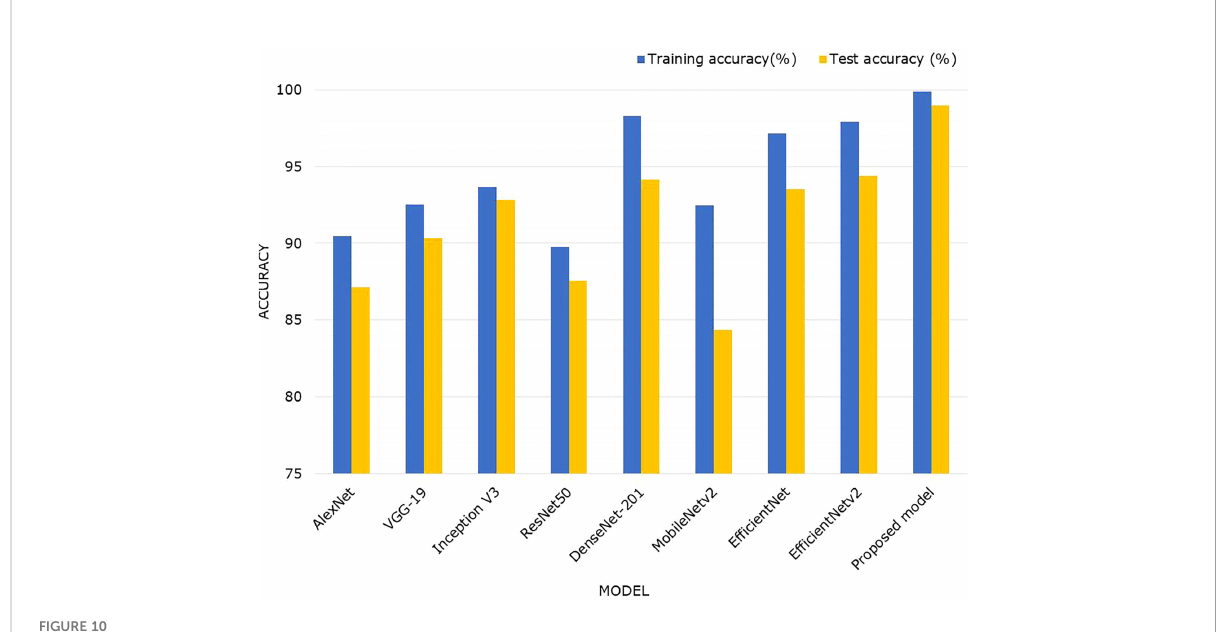
FIGURE 10 Performance comparison of the proposed technique with other CNN